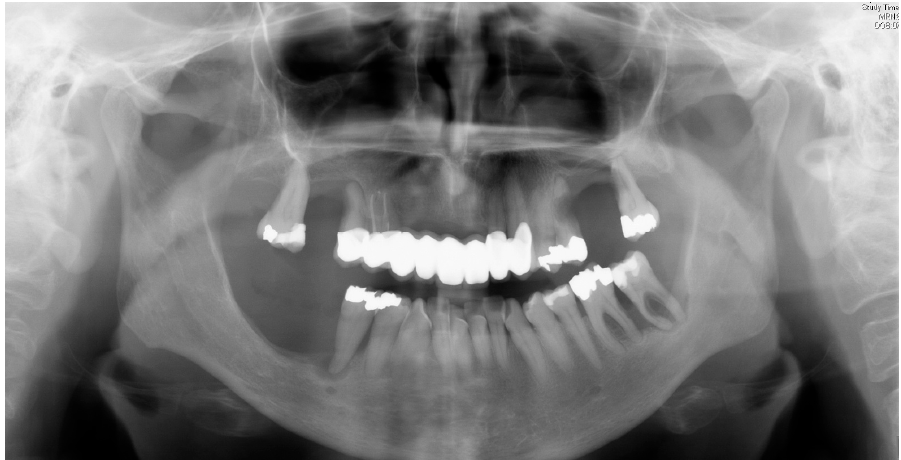
Figure 2. Excessive periodontal destruction in a 48-year-old women with Langerhans cell histiocytosis.